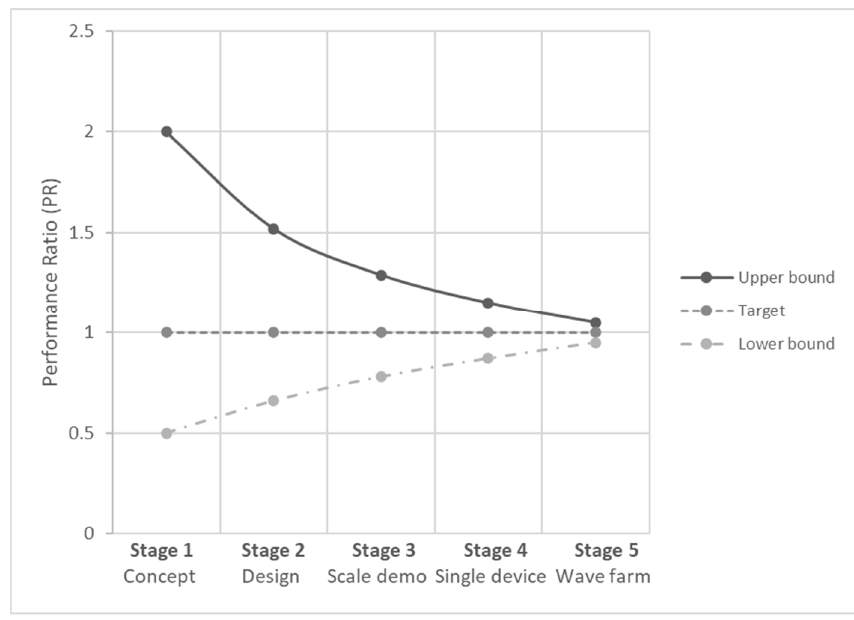
Figure 15. Expected accuracy range per development stage.